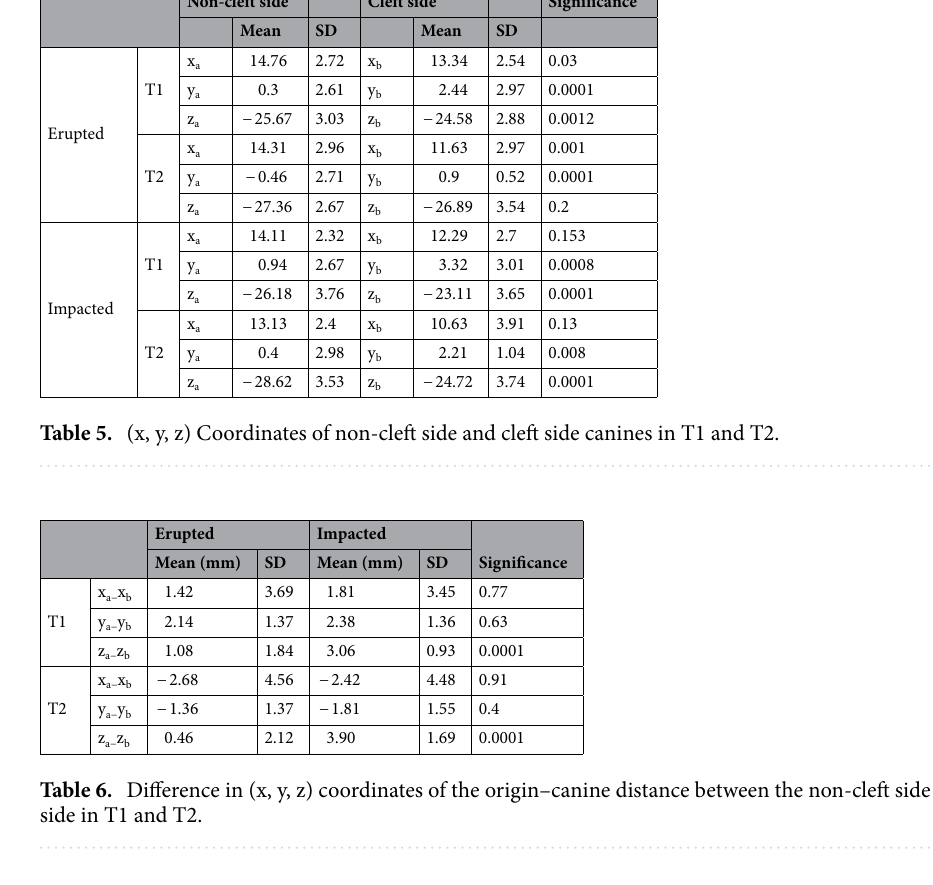
95% CI for O.R. B S.E. p O.R. Lower Upper